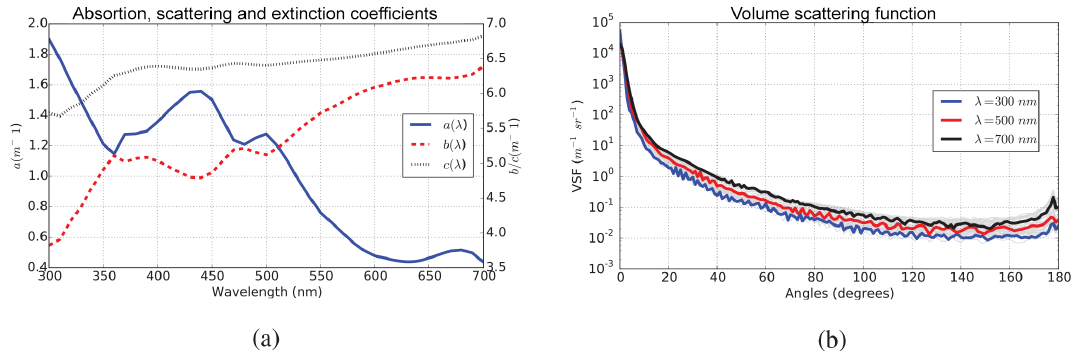
Figure 10. (a) Absorption ( a(λ) ), scattering ( b(λ) ), and extinction ( c(λ) ) coefficients and (b) volume scattering function for spherical-shaped coated particles.